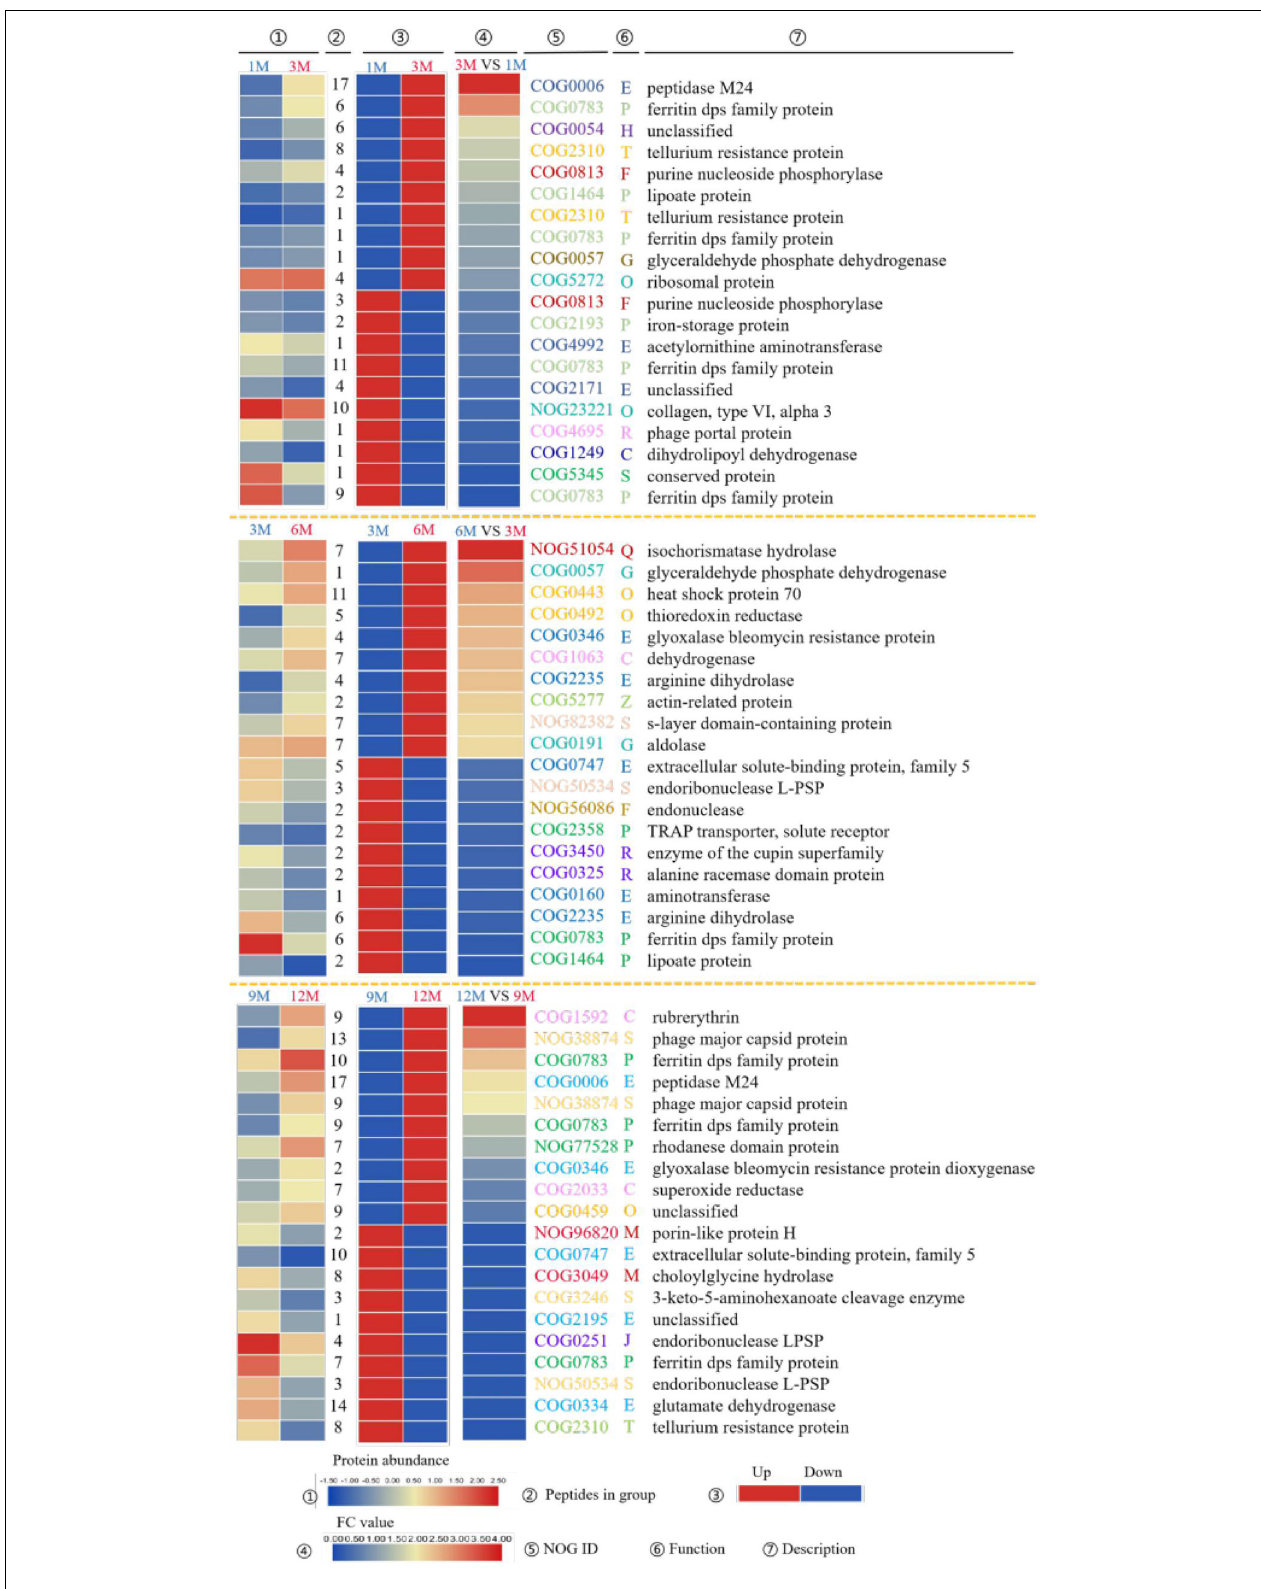
FIGURE 3 | EggNOG annotations of differentially expressed proteins (DEPs) of traditional fish sauce based on metagenomics.